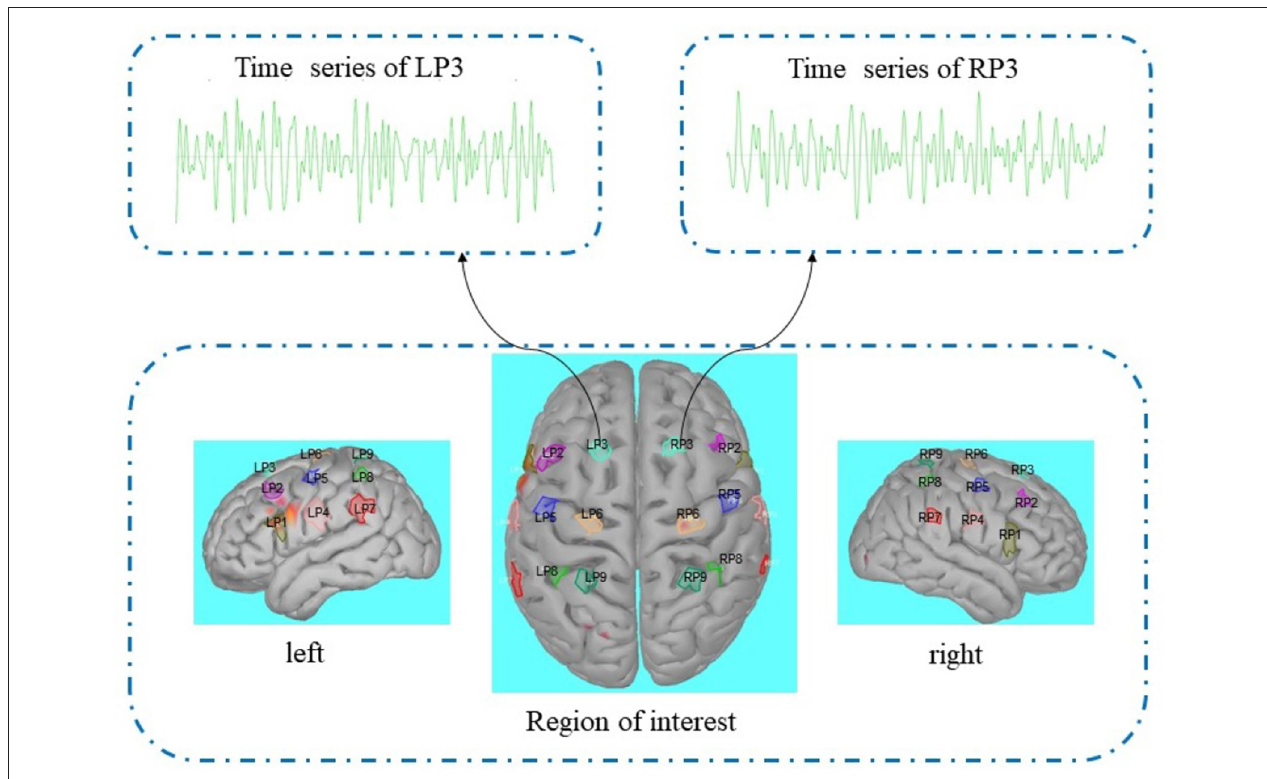
FIGURE 2 | Cortex